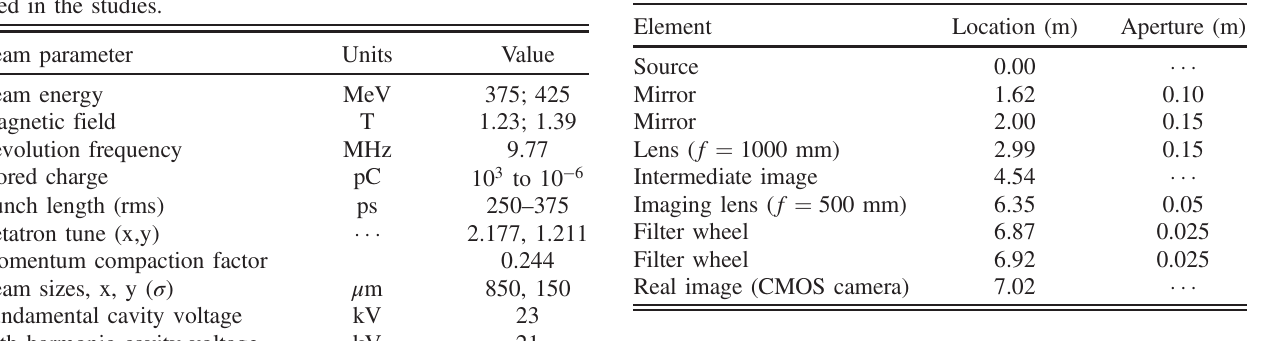
TABLE II. Optical elements in the CMOS camera path.